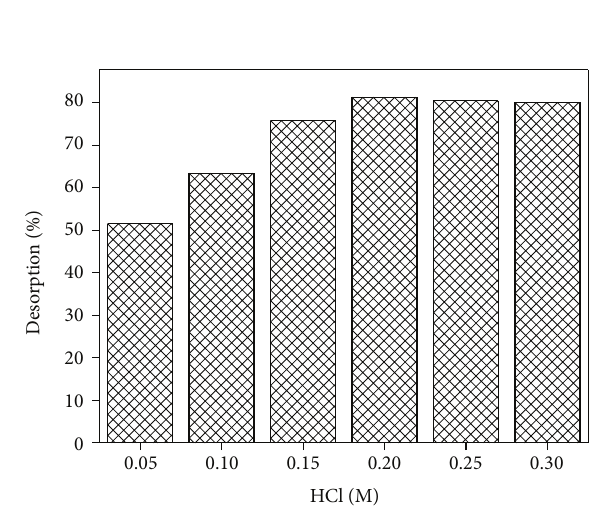
Figure 8: Desorption of Cd(II) ions from WAS.